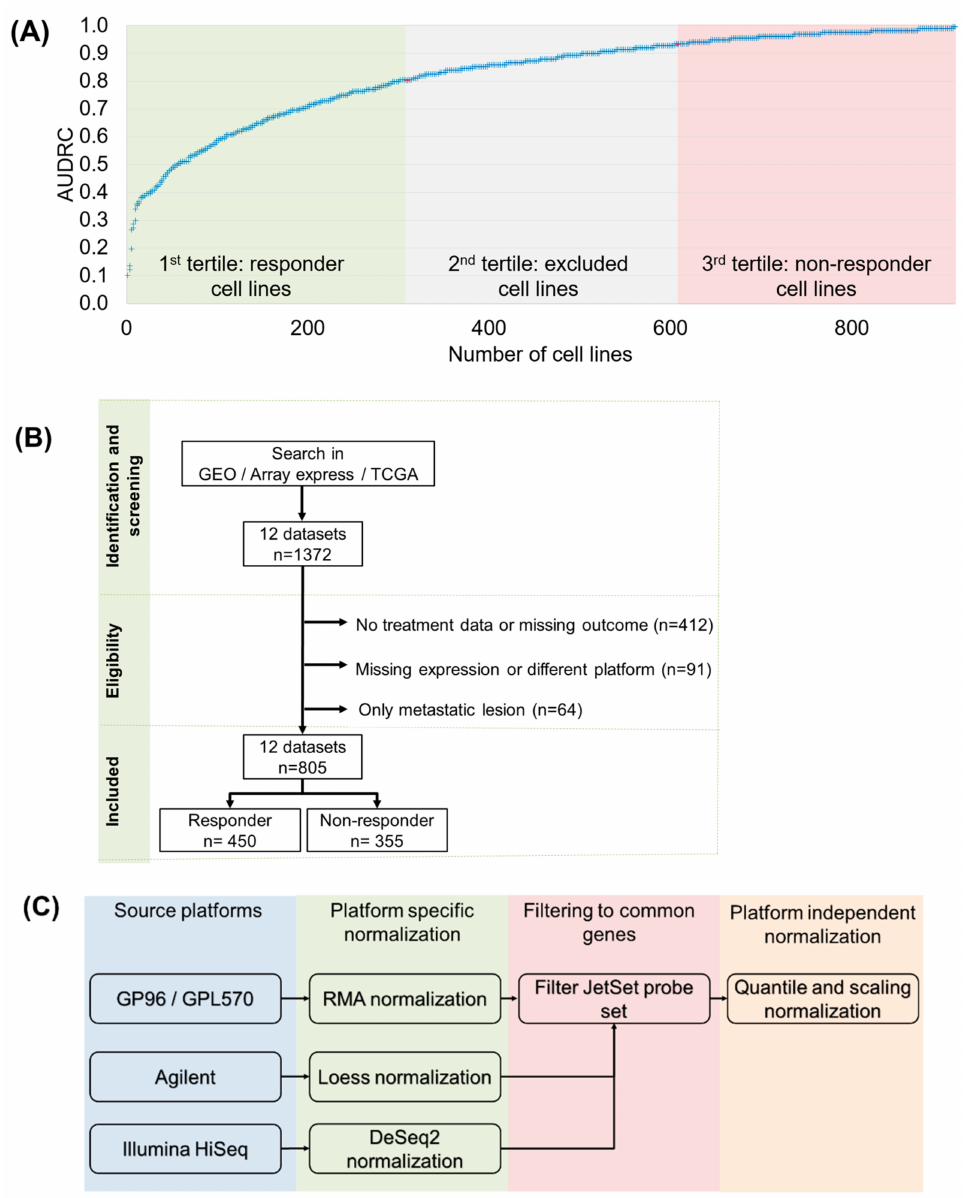
Figure 1. Overview of the data processing steps. Summary of response classification using the area under the dose–response curve (AUDRC) values in the 5FU-treated cell lines ( A ). Outline of the clinical database setup ( B ) and the pipeline employed for transcriptomic data pre-processing ( C